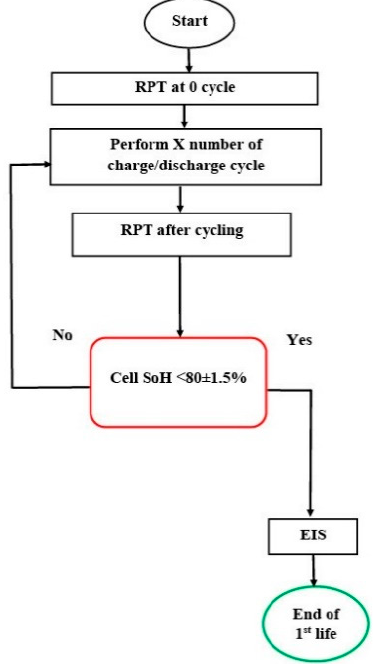
Figure 4. The progression of the ageing test of the individual cell.